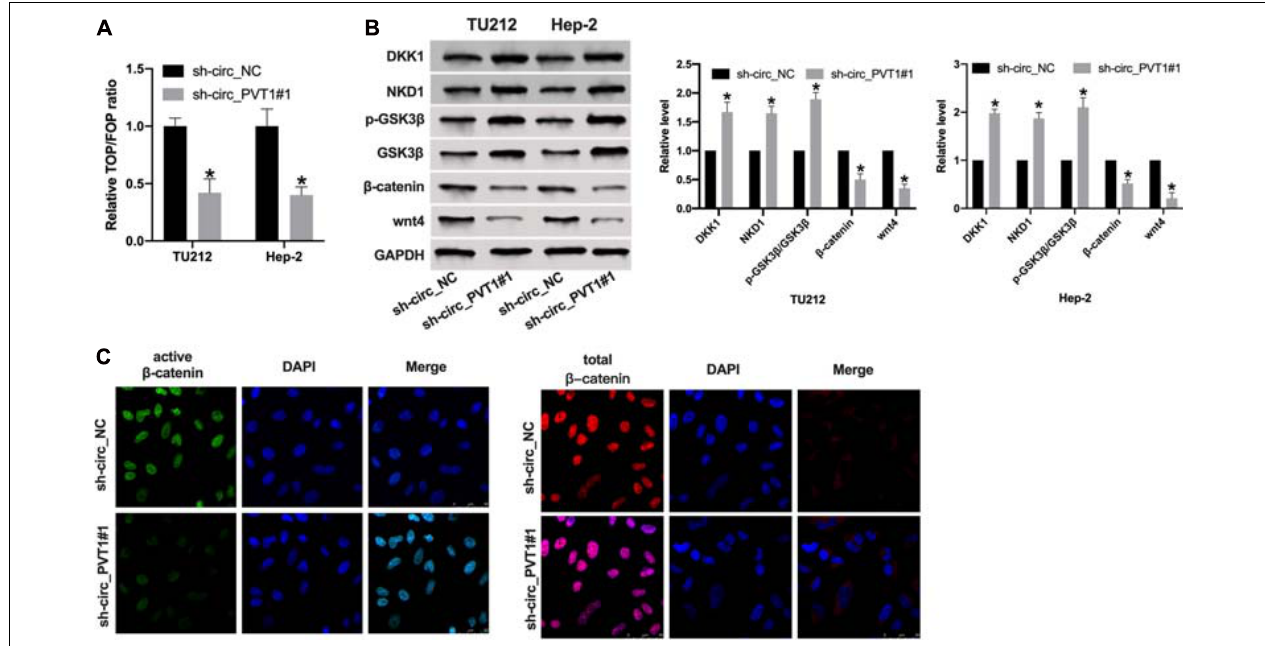
FIGURE 4 | Silencing of circ_PVT1 inhibits wnt/ β -catenin signal pathway. (A) The LOP/FOP luciferase assay. * P < 0.05, n = 4. (B) The protein level of DKK1, NKD1, phosphorylation-GSK3 β (p-GSK3 β ), GSK3 β , β -catenin, and wnt4 in LC cells. * P < 0.05, n = 4. (C) Subcellular localization of active β -catenin and total β -catenin in Hep-2 cells by immunofluorescence